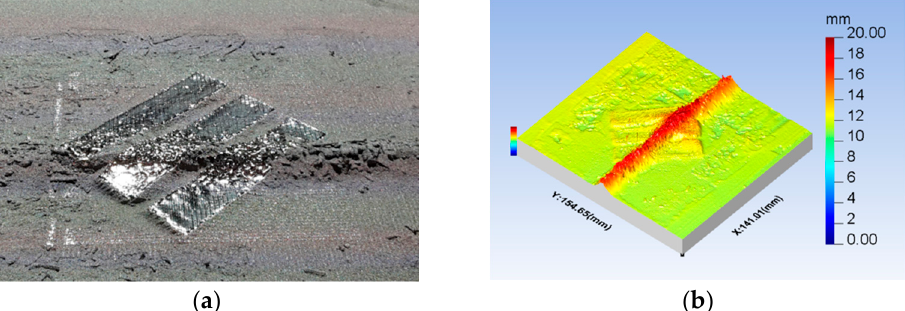
Figure 15. 3D measurement results of printed tensile test parts: ( a ) optical camera image; ( b ) measurement of printed layer showing test parts and excess powder delivery due to rake damage.